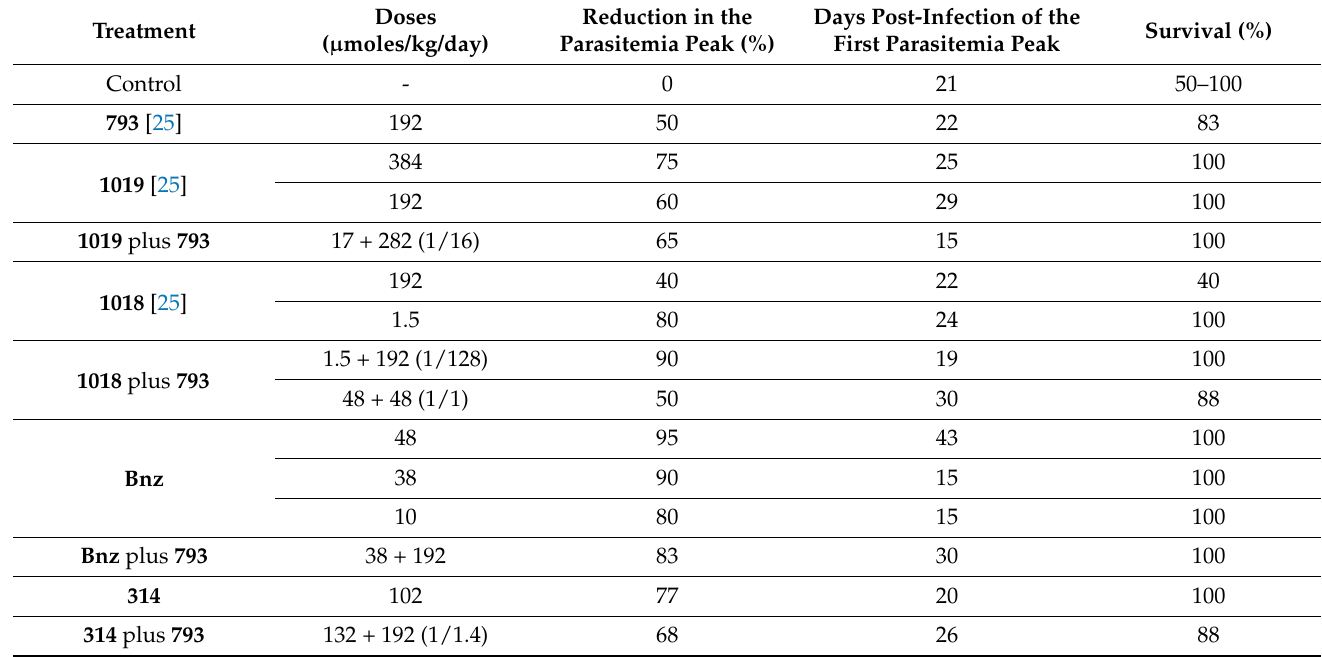
Table 5. Summary of the in vivo trials. It is showing the most promising results regarding the evaluation of compounds in monotherapy and